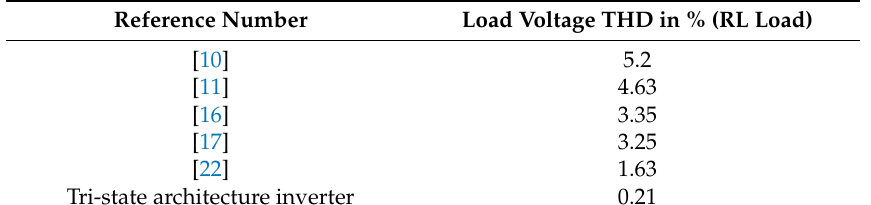
Table 8. Presence of harmonic content in load waveform of various MLI designs.